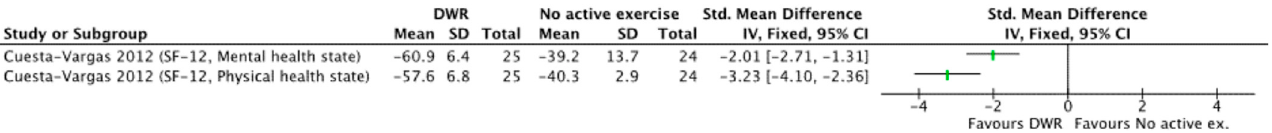
Figure 6. Standardized mean difference (95% CI) for the effect of DWR compared with no active exercise on QoL [23].